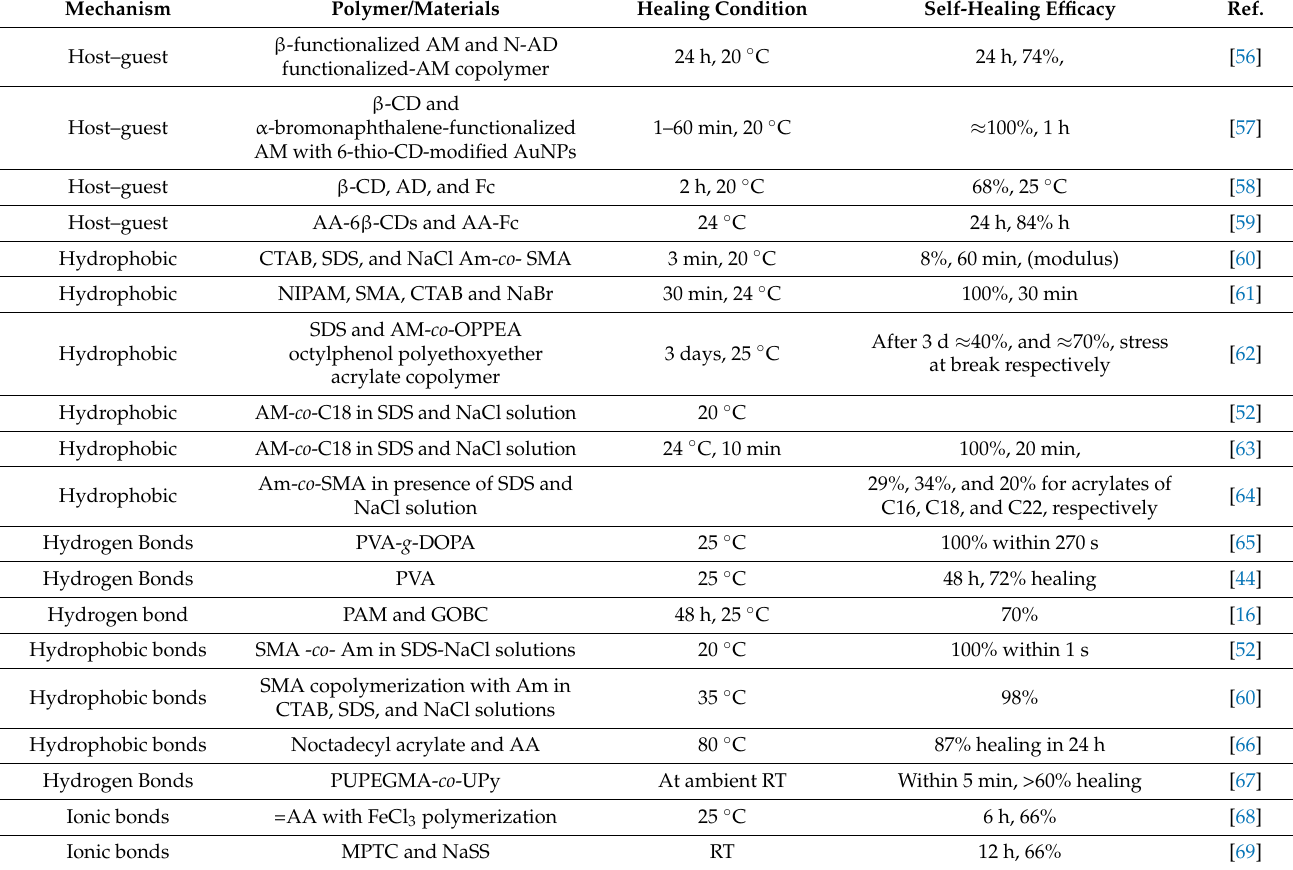
Table 1. Comparison of self-healing efficiency of various hydrogels prepared through different